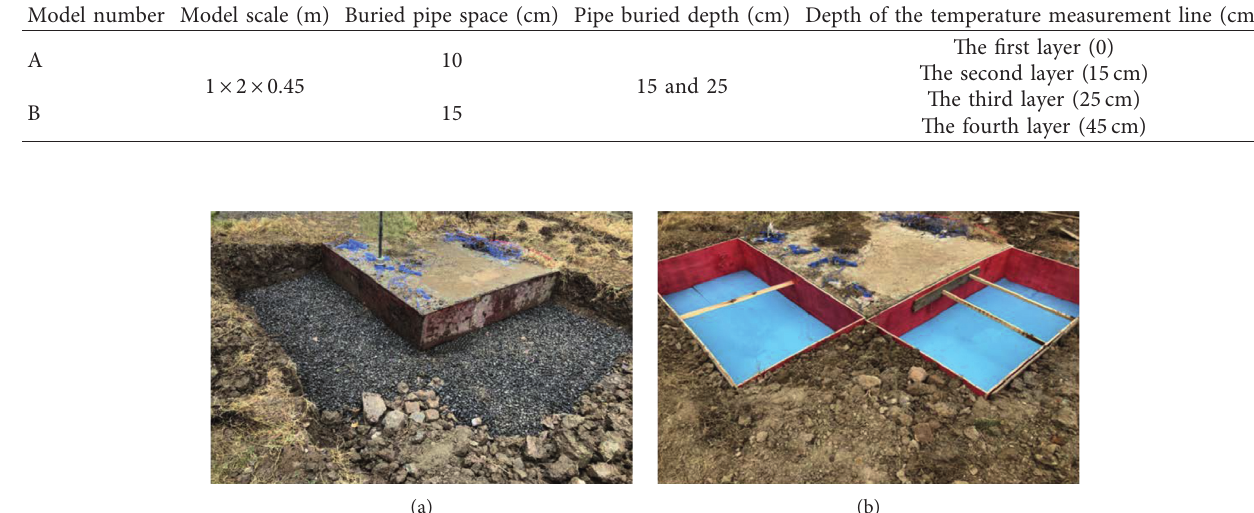
Table 1: Detailed model design parameters.